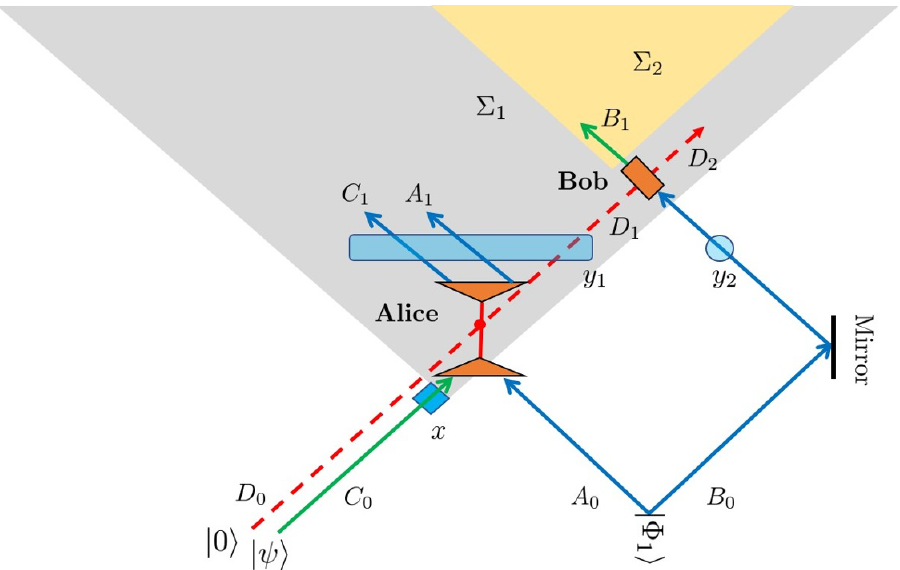
Figure 17 . A spacetime diagram of the quantum teleportation protocol. Space runs horizontally, and time runs vertically from bottom to top. The consequence of teleportation is that the future of x (the teleportee C 0 right before teleportation happens) shrinks from the ordinary future light cone (cid:6) 1 to a subset (cid:6) 2 (the future of the point where teleportation is (cid:12)nished). Note that the EPR pair of A 0 ; B 0 is still outside the future of x , as is expected by microscopic